Question: In one sentence, what is this figure communicating?
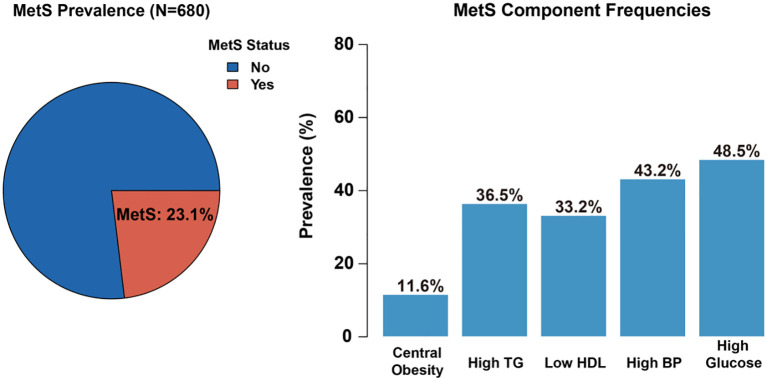
Answer: Multivariable cox regression analysis for disease-free survival.